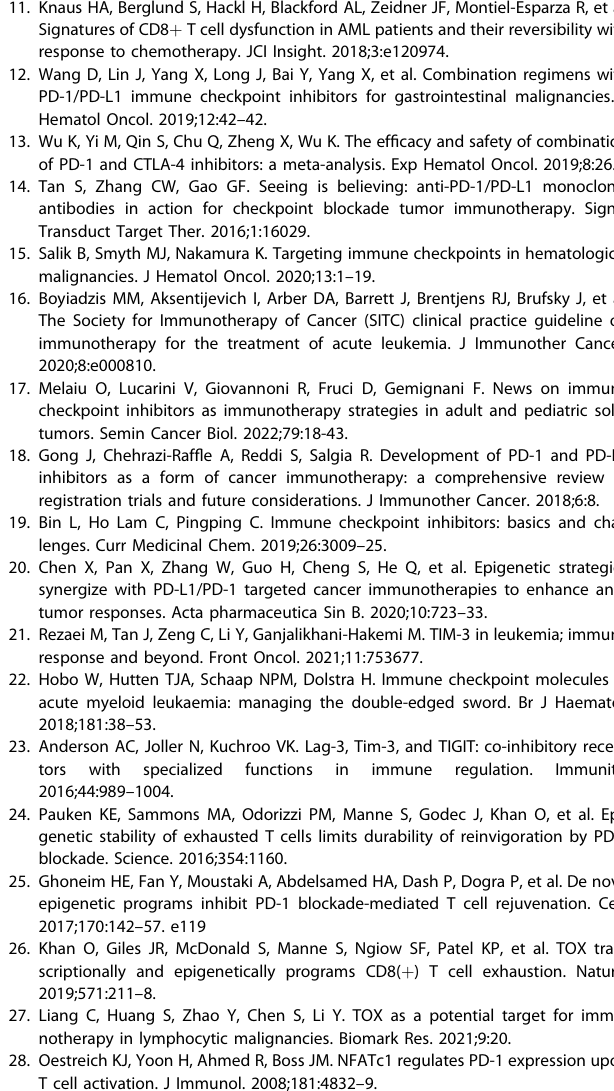
Fig. 7 BET inhibitor suppresses PD-1 and Tim-3 expression, and prolongs survival in murine AML and B-ALL leukemia model. A Structural diagram of in vivo experiment treated with JQ1 ( n = 6 mice per group in this experiment, n = 3 mice per group in the repeated experiment, n (total) = 9 mice). B The percentages of GFP + leukemia cells in peripheral blood were detected by FACS every 2 days after DMSO or JQ1 administration ( n = 6 mice per group). C The expression of PD-1 on CD3 + T cells in peripheral blood was detected by FACS every 2 days after DMSO or JQ1 administration ( n = 6 mice per group). D The expression of Tim-3 on CD3 + T cells in peripheral blood was detected by FACS every 2 days after DMSO or JQ1 administration ( n = 6 mice per group). E The expression of PD-L1 on GFP + T cells in peripheral blood was detected by FACS every 2 days after DMSO or JQ1 administration ( n = 6 mice per group). F Kaplan – Meier curve after MLL-AF9 leukemia cells transplantation ( n = 6 mice per group, statistical signi fi cance calculated using a log-rank test). G Weight change of each mouse in DMSO or JQ1-treated group ( n = 6 mice per group). H Structural diagram of in vivo experiment treated with anti-CD3 and JQ1 ( n (total) = 5 mice per group). I Kaplan – Meier curve after MLL-AF9 leukemia cells transplantation ( n = 5 mice per group). J Treatment schedule and experimental design. B-NDG mice were injected with 1 × l0 5 Nalm6 cells on day 0, followed by 5 × l0 6 GFP-T or DMSO-CAR19-T or JQ1-CAR19-T on day 6. Bioluminescence imaging was performed weekly after T-cell administration ( n = 5 mice per group in this experiment, n = 6 mice per group in the repeated experiment, n (total) = 11 mice). K The dorsal BLI signal is displayed for individual mice in each treatment group ( n = 5 mice per group). L D4-28 bioluminescence imaging of tumor growth ( n = 5 mice per group). M Weight change of each mouse in each treatment group ( n = 5 mice per group). N Kaplan – Meier survival plot for mice receiving GFP-T or CAR T cells pretreated with DMSO or JQ1 ( n = 5 mice per group). O Schematic representation of the mechanism underlying BRD4 inhibition leading to improve T-cell ef fi cacy. Left: BRD4 and NFAT2 involve in the transcription of PDCD1 and HAVCR2. Right: BRD4 inhibitor JQ1 blocks the binding of BRD4 to NFAT2 promoter to prevent the transcription of NFAT2, which inhibits the transcription of PDCD1 and HAVCR2. Besides, JQ1 blocks the binding of BRD4 to the PDCD1 promoter, thus directly inhibiting the expression of PD-1. In short, BRD4 inhibitor inhibits the expression of PD-1 and Tim-3, and increases the secretion of cytokines may partly through NFAT2 signaling pathway. Data are expressed as mean ± SD. n = 3 or more independent biological replicates, presented as individual points. P value < 0.05 was considered to be signi fi cant ( B – D : one-way ANOVA with Bonferroni post hoc test; G , K , M : two-way ANOVA; E : two-tailed unpaired Student ’ s t tests; F , I , N : log-rank